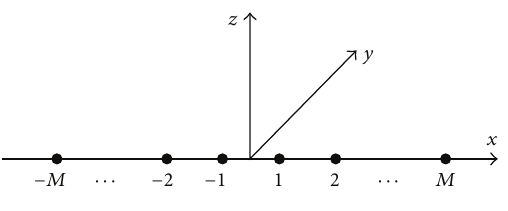
Figure 1: A uniform linear symmetric